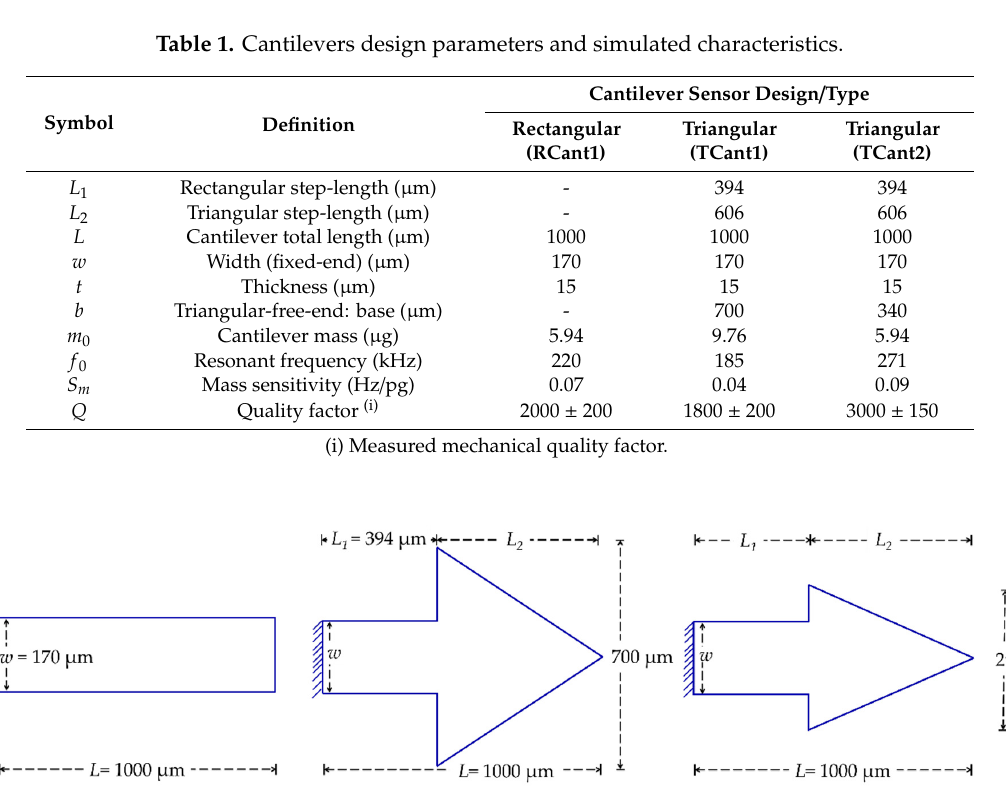
Table 1. Cantilevers design parameters and simulated characteristics.